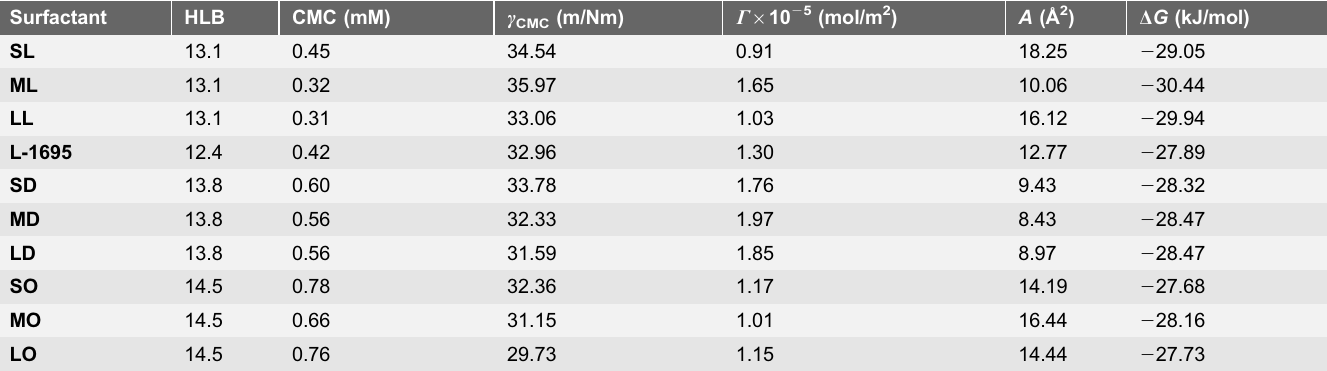
disaccharide fatty acid monoesters with carbon chain lengths from C12 to C16